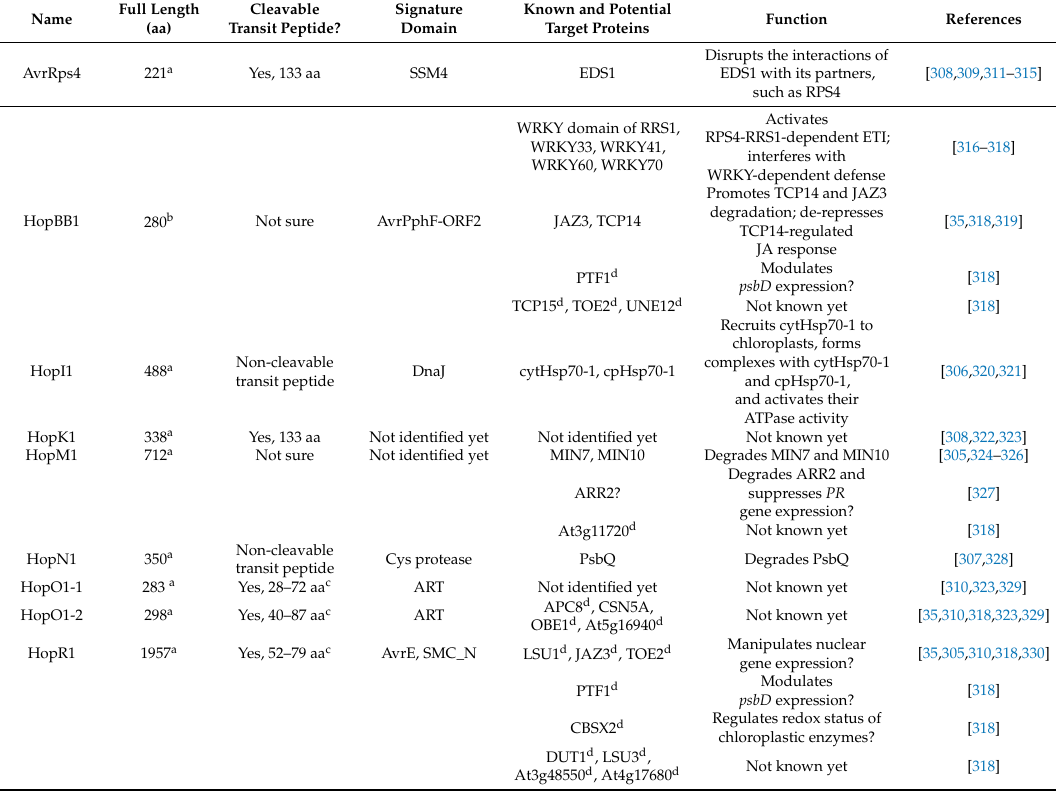
Table 1. Known and potential plastid-targeted bacterial